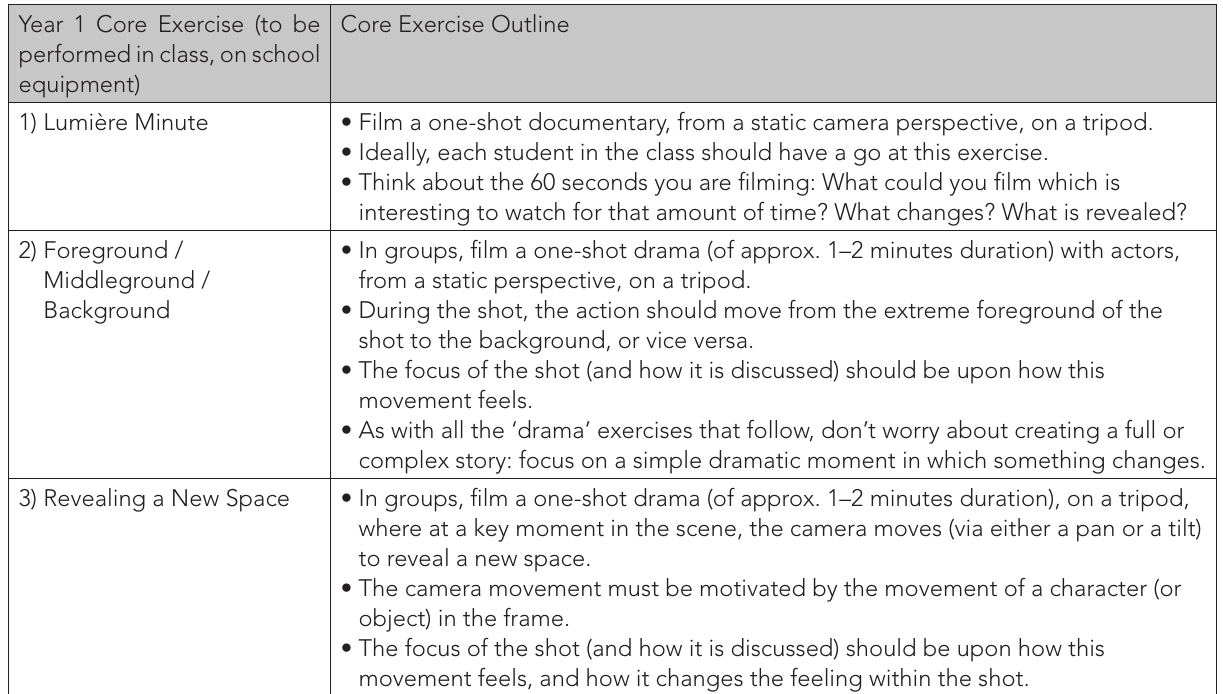
Table 1a. Year 1 – Within a Single